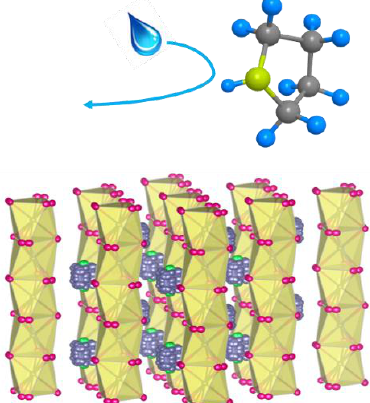
Figure 8. Schematic illustration of water-repelling mechanism in PyPbI 3 . The top five-membered ring stands for the Py molecule, and structure beneath represents PyPbI 3 perovskite.